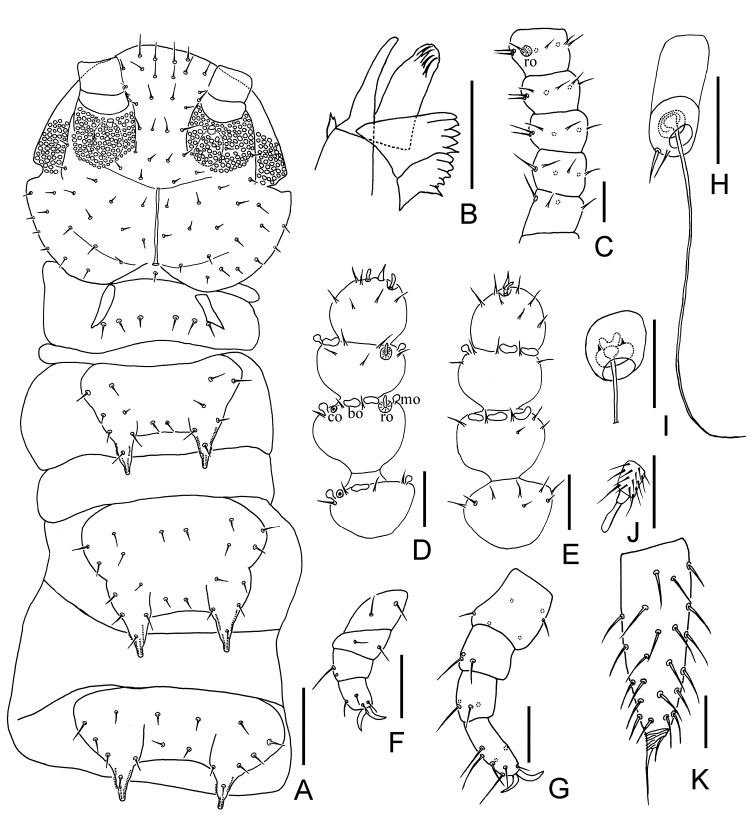
Scolopendrellopsisglabrus sp. n. (Holotype) A head and 1st–4th tergites B mandible and first maxilla C 1st–5th segments of right antenna D–E 13th–16th of right antenna D dorsal view E ventral view F first leg G 12th leg H left sense calicles, dorsal view I right sense calicles, dorsal view J stylus on base of 11th leg K right cercus, dorsal view. Scale bars: 50 μm (A), 20 μm (B–I, K), 5 μm (J).